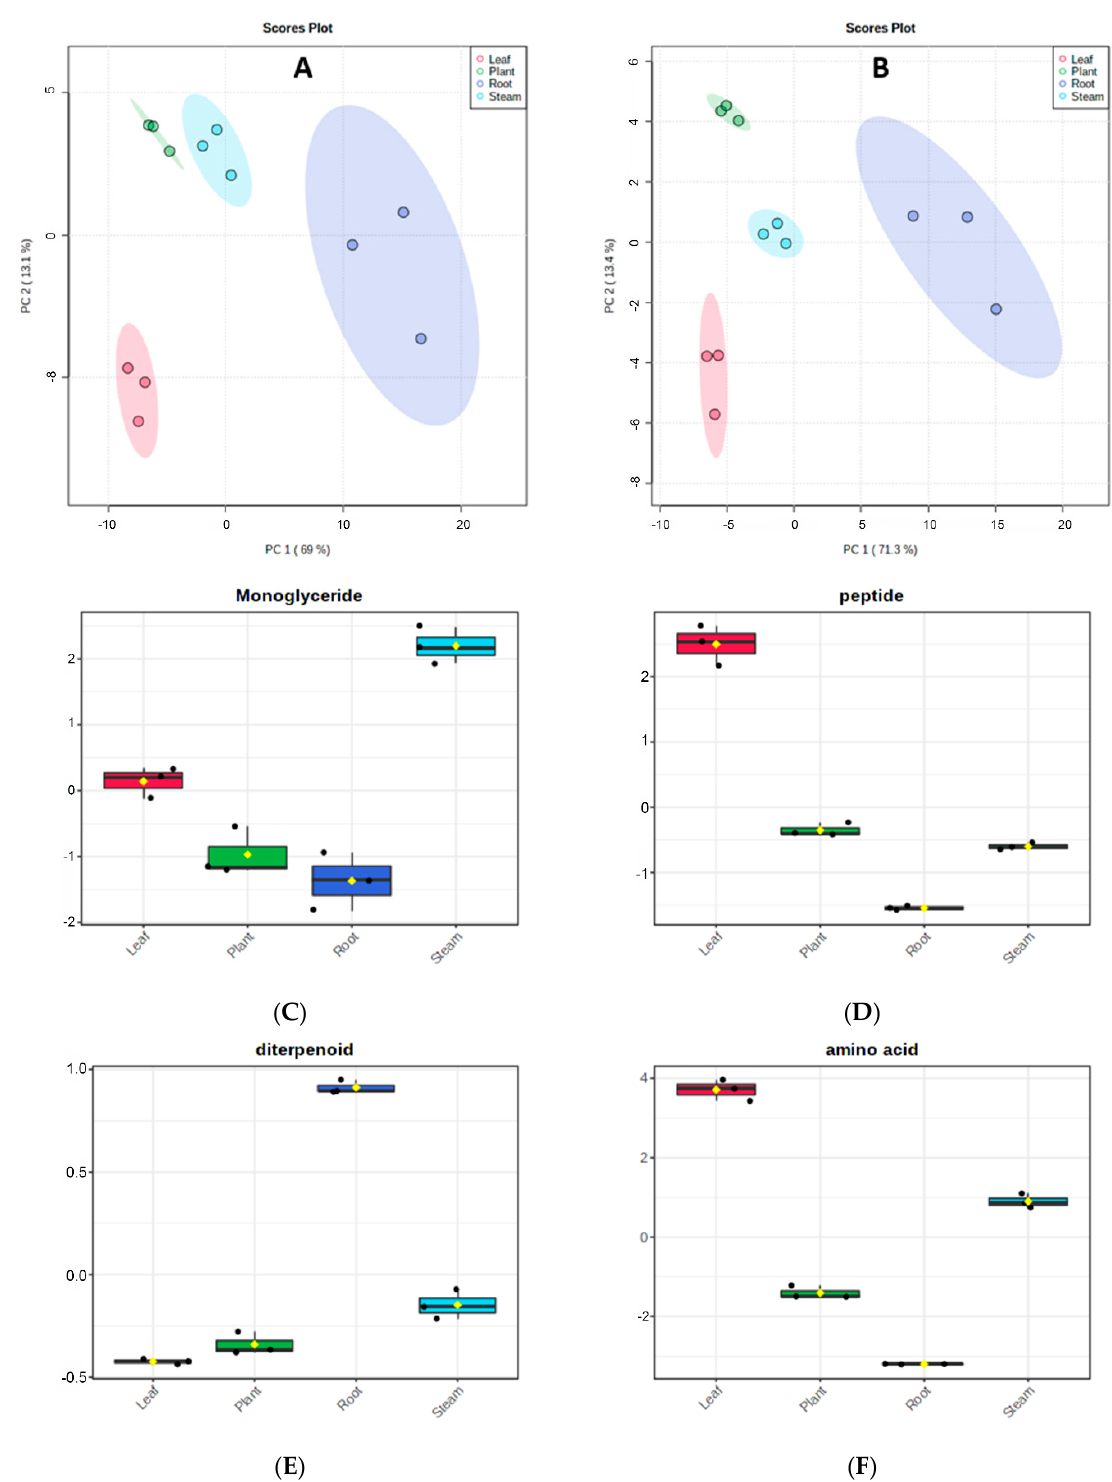
Figure 1. Principal Component Analysis (PCA) score plot of the four tested plant parts. ( A ) 67 annotated metabolites. ( B ) Ontology group of 34 annotated metabolites. Total quantitative variances of metabolites or ontology grouped metabolites were clustered to reveal the difference and relative similarities of different plant materials. 95% confidence regions (Hotelling’s T2 eclipse) are displayed for each class. Monoglyceride fraction was particularly present in stem ( C ), rather than in the other plant parts. By contrast, peptides and diterpenoids were found at higher levels in leaf ( D ) and root ( E ), respectively, whereas amino acids were particularly present in the leaf ( F ).